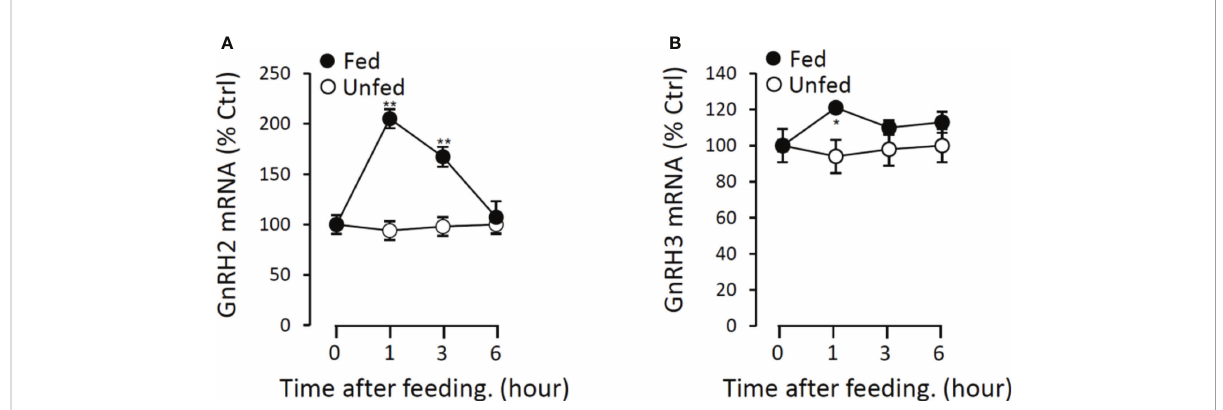
FIGURE 13 Postprandial changes of GnRH2 (A) and GnRH3 (B) mRNA expression in grass carp. Grass carp were temporarily raised in a well-aerated 250-l storage pond and fed one meal per day for at least 7 days on fi xed times (9:00 a.m.). The brains were harvested at 0, 1, 3, and 6 h after food administration. Then, the total RNA were extracted to detect the GnRH mRNA level expression by the RT-PCR system. Data presented are expressed as mean ± SEM, and the differences between groups were signi fi cant at p < 0.05 by labeling symbol “ * ” ( “ ** ” means p < 0.01).